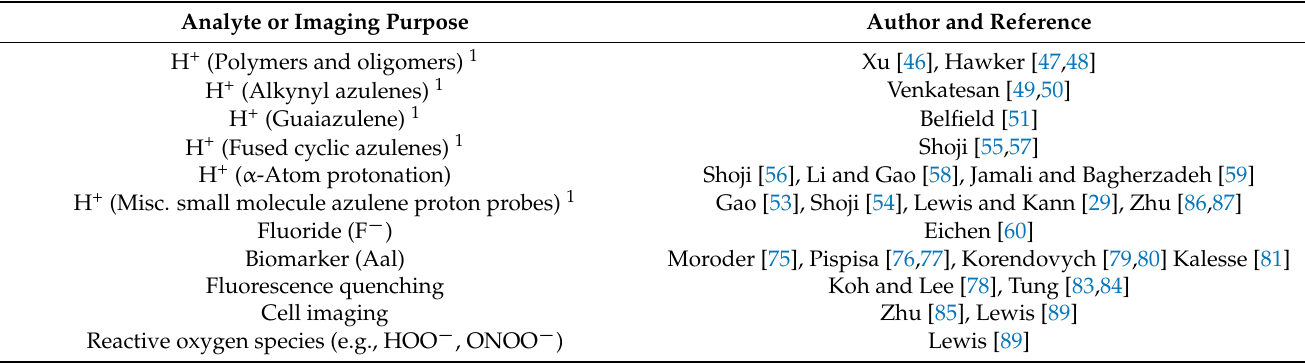
Table 1. Summary of fluorescent azulene-based sensors, dosimeters and imaging agents with accompanying references. Analyte or Imaging